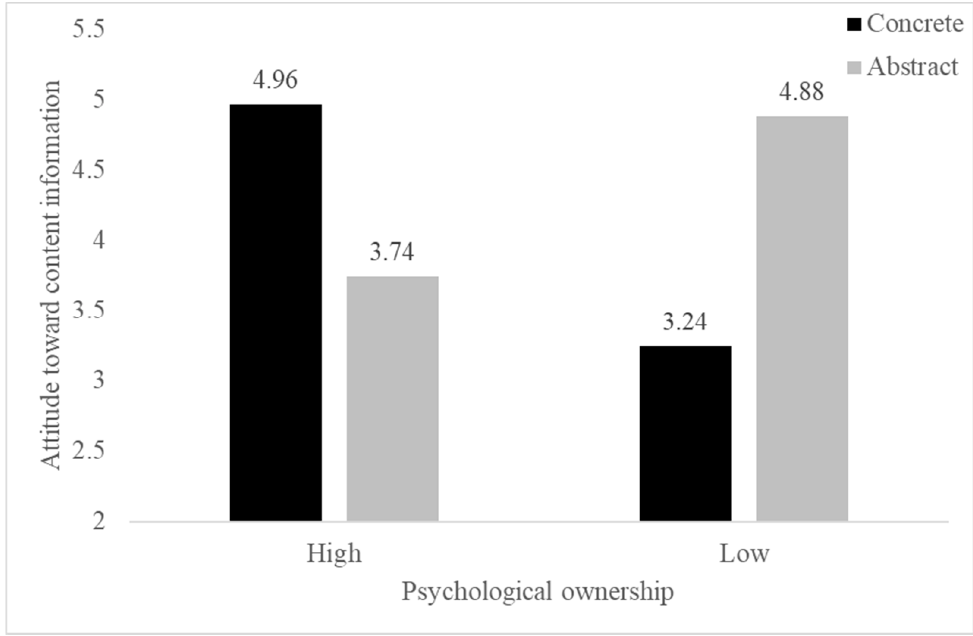
Figure 3. Interaction effect of psychological ownership and recommendation message on attitude toward content information. Table 4. Multiple comparison test to attitude toward content